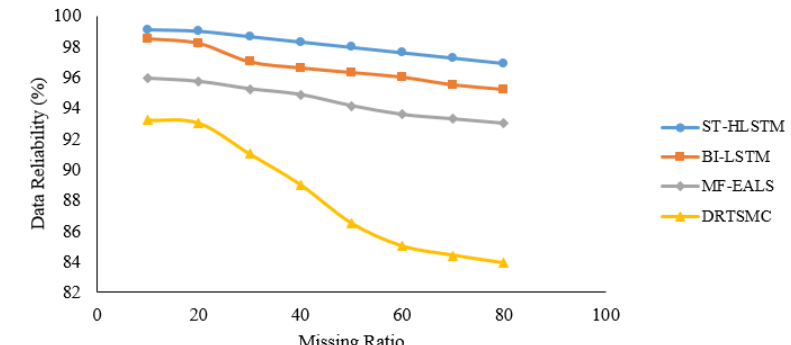
Figure 7. Reliability of Node12.